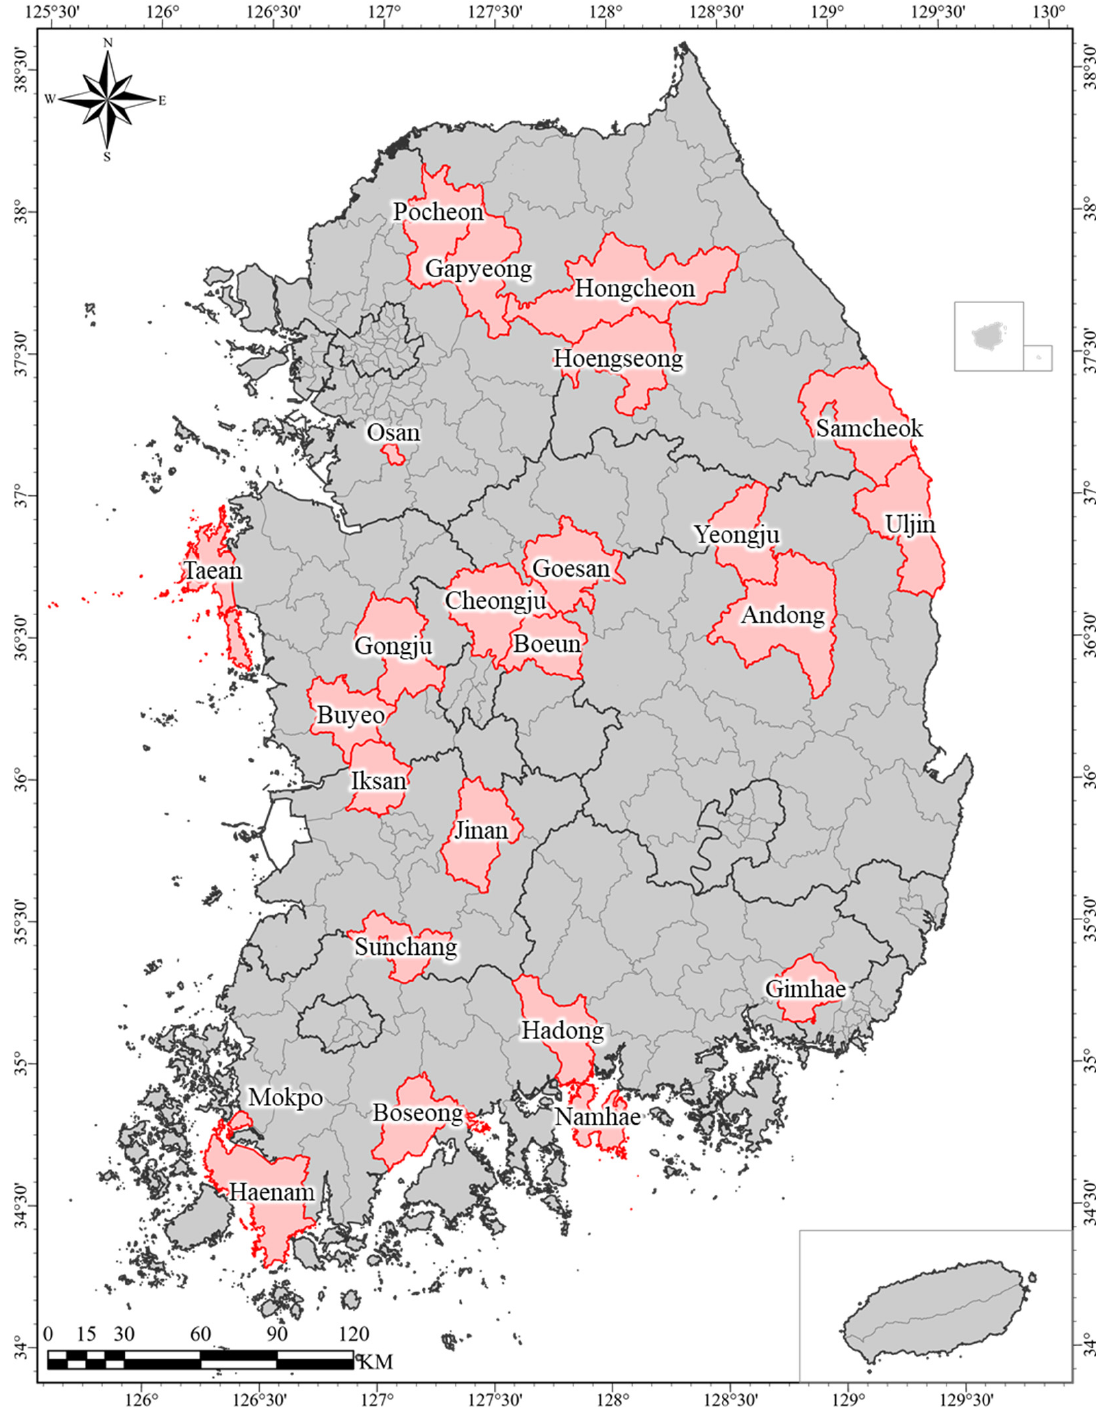
Figure 1. Survey sites (24 counties/cities) in South Korea.